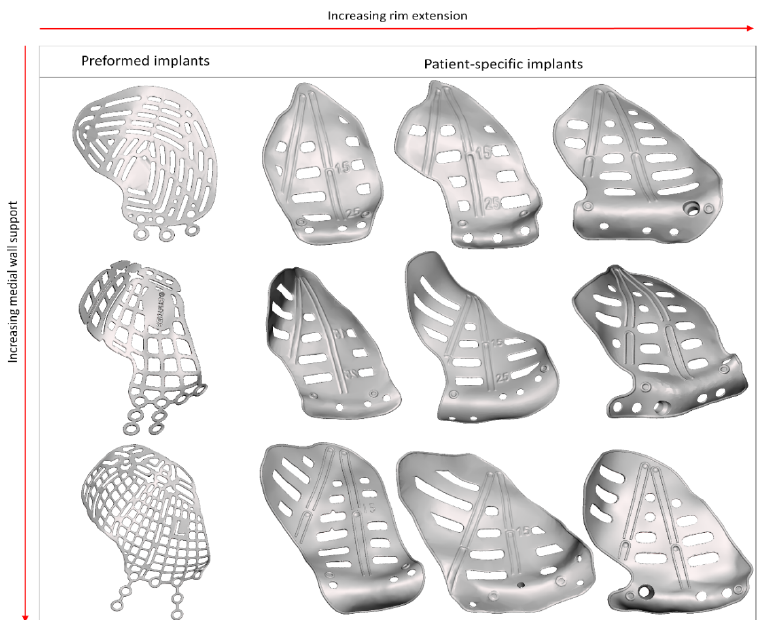
Figure 4. Examples of two patient-specific implant designs with overcorrection (red contour) of the mirrored orbital volume (yellow contour). The first patient-specific implant is designed with an an- terior elevation at the infra-orbital rim to compensate for the asymmetry in globe position ( A , B ). The second patient-specific implant is designed with a large overcorrection for an anophthalmic socket reconstruction ( C , D ).